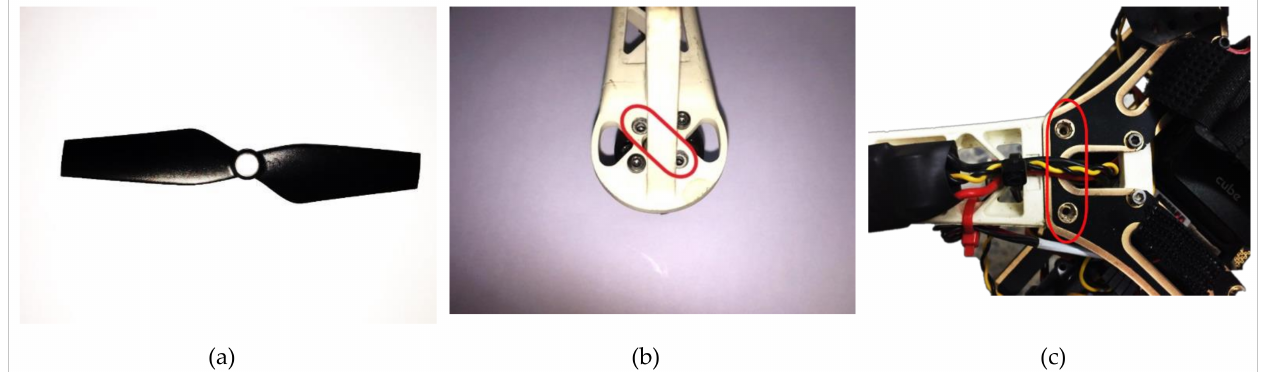
Figure 4. Fault states: ( a ) the damaged propeller; ( b ) loosening of the motor screw; ( c ) loosening of the arm